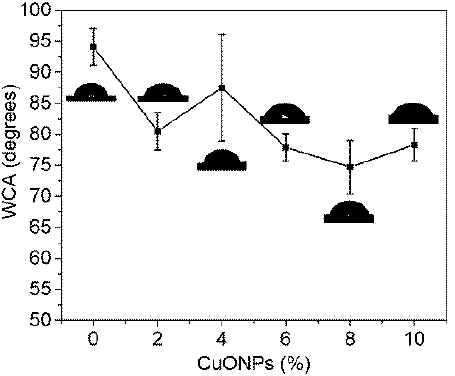
Figure 7. Dependence of the water contact angle with the amount of CuONPs (wt %).